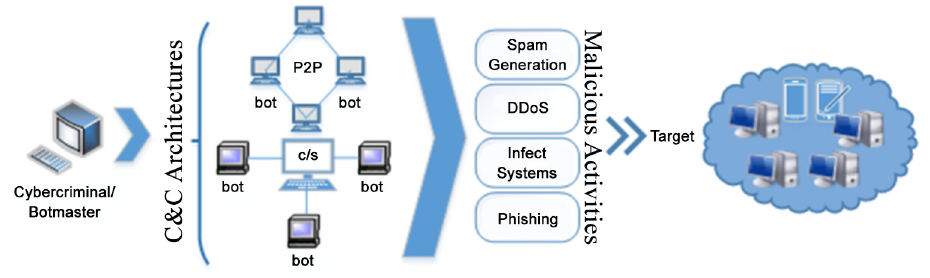
Fig 1. Basic Botnet